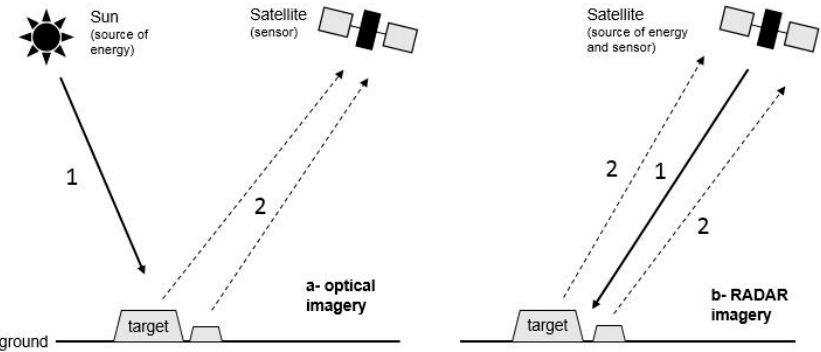
Figure 3. Principles of passive (optical) and active (SAR) satellite sensors. 1 = transmitted wave, 2 = received waves.